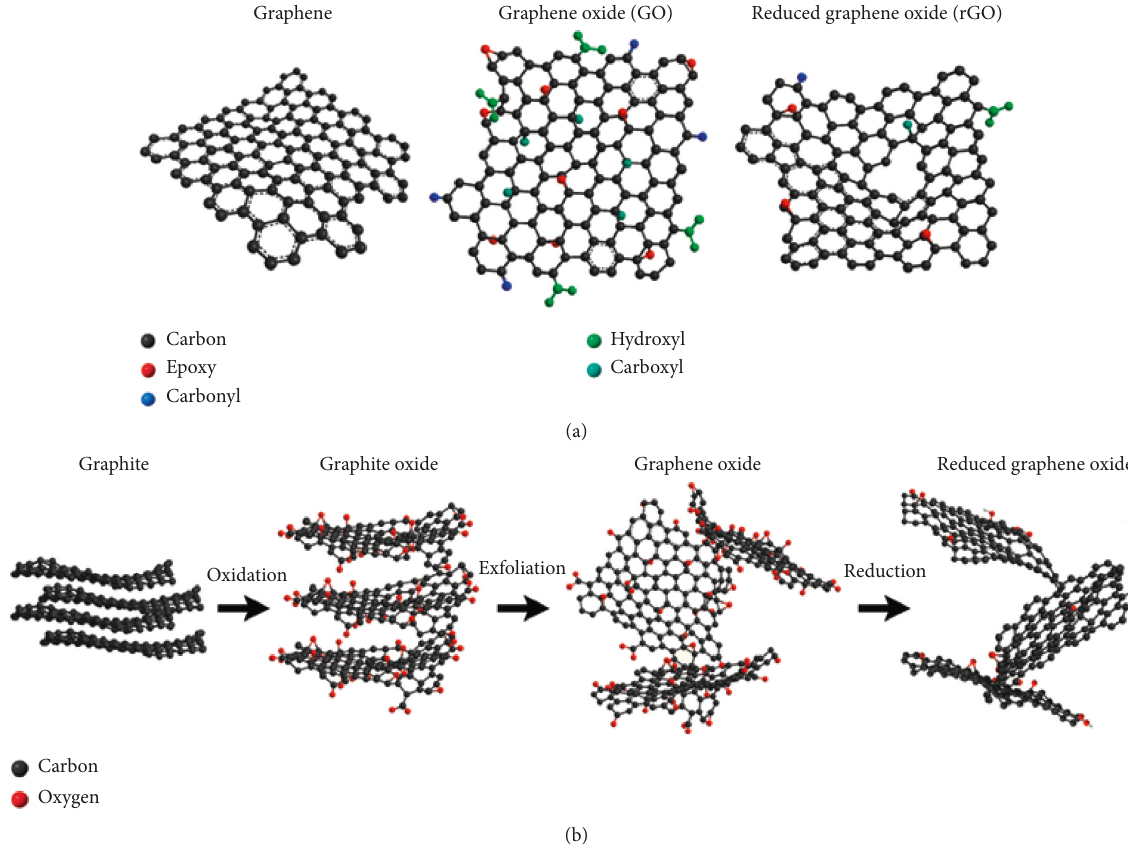
Figure 1: Graphene and graphene composite structures.